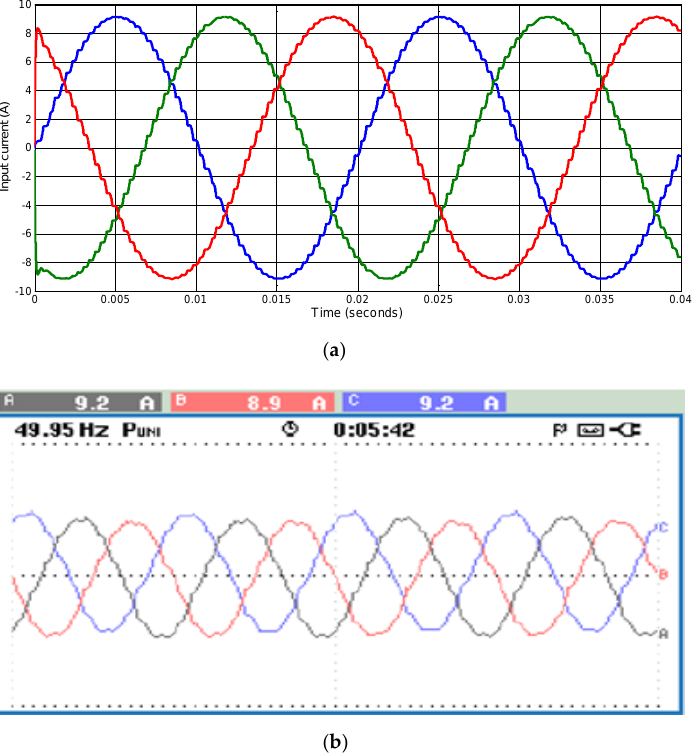
Figure 10. The three-phase AC input current: ( a ) simulation results, ( b ) experimental results.